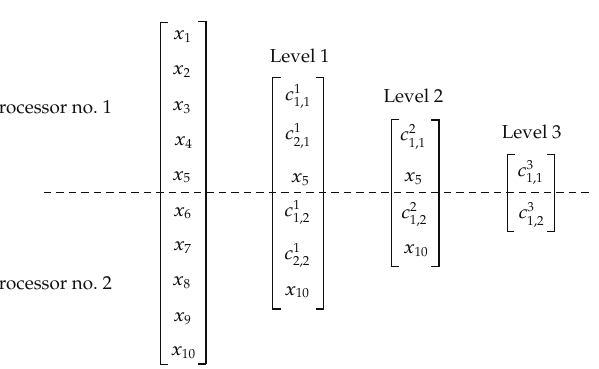
Figure 2: Illustration of the 1D parallel wavelet transform with 2 processors.